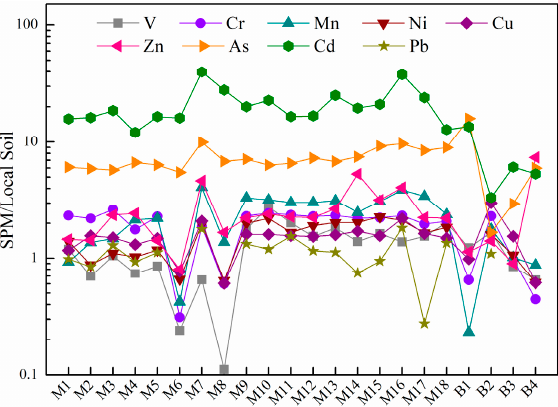
Figure 2. Abundances of nine heavy metal(loid)s in SPM normalized to local soil in the Zhujiang River.